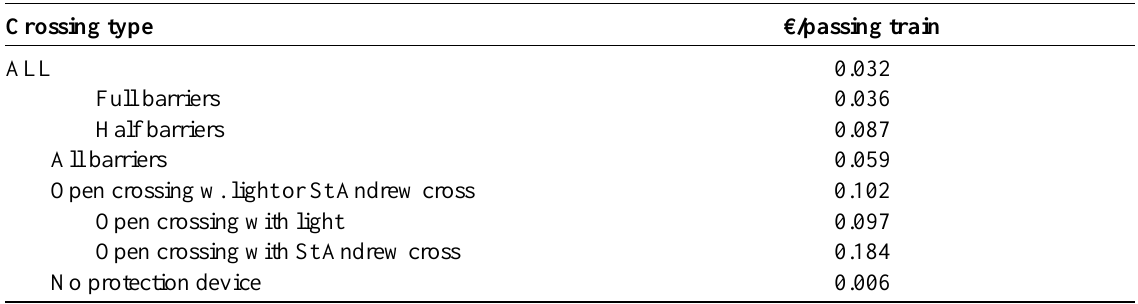
Table 4. Marginal accident cost for trains at road-rail level crossings (€/train passage) Crossing type ALL